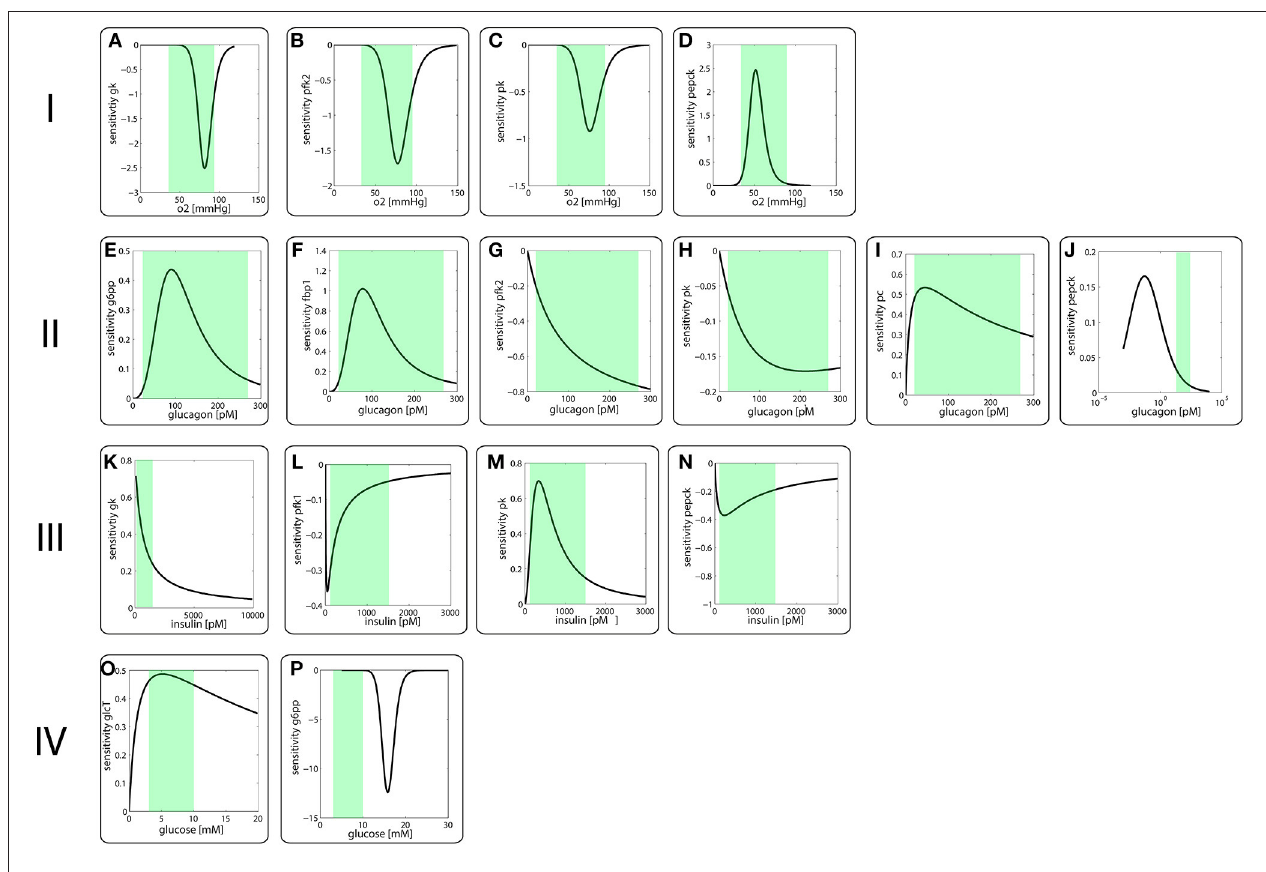
FIGURE 2 | Sensitivity coefficients of protein turnover rates defined in equation (3) as function of modulator concentrations. I Sensitivity of protein turnover rates with respect to oxygen of (A) GK, (B) FBPFK2, (C) PK, (D) PEPCK II Sensitivity of protein turnover rates with respect to (E) G6PP, (F) FBP1, (G) FBPFK2, (H) PK, (I) PC, (J) PEPCK III Sensitivity of protein turnover rates with respect to (K) GK, (L) PFK1, (M) PK, (N) PEPCK IV Sensitivity of protein turnover rates with respect to (O) GlcT, (P) G6PP The green-shades areas indicate the reported physiological concentration range of the respective modulator.